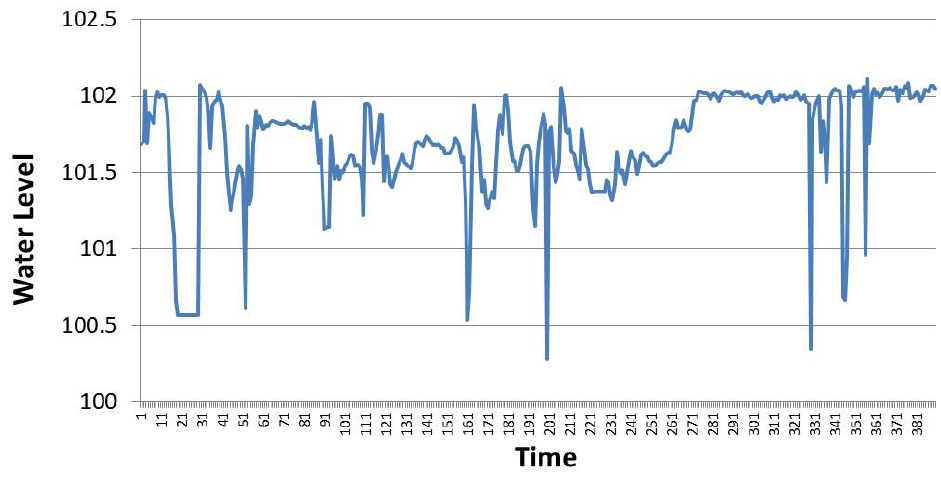
Figure 5. Incirli Reservoir water surface elevation time series for May 2016. Temporal resolution is 15 min.